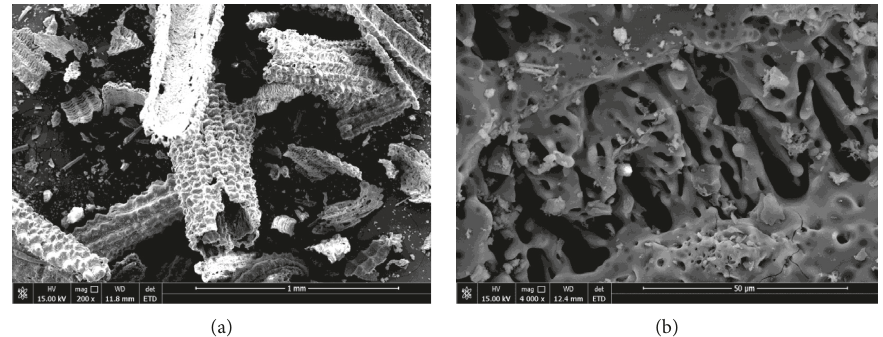
Figure 3: Microstructure of the natural RHA. (a) RHA particle at low magnification (200x); (b) RHA particle at magnification (4,000x).